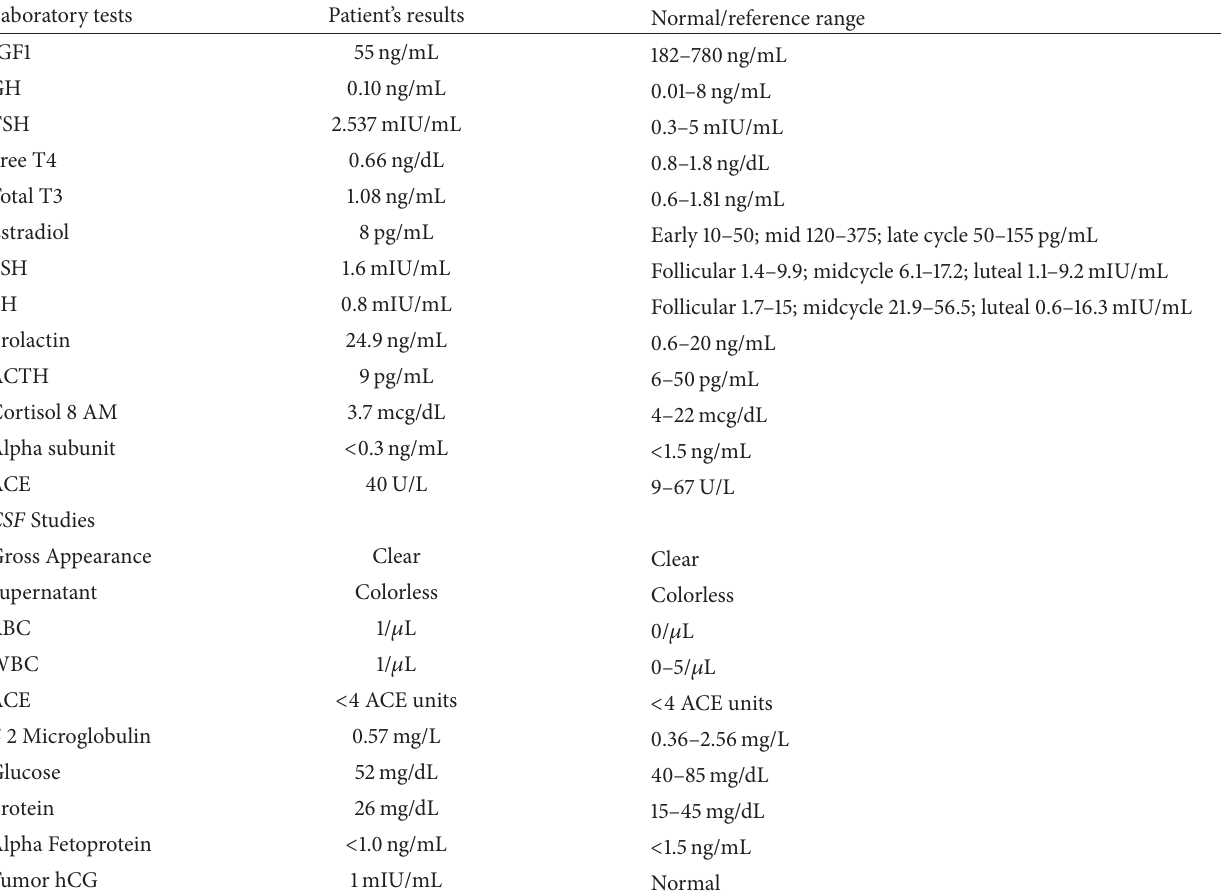
Table 1: Laboratory studies and CSF studies at initial